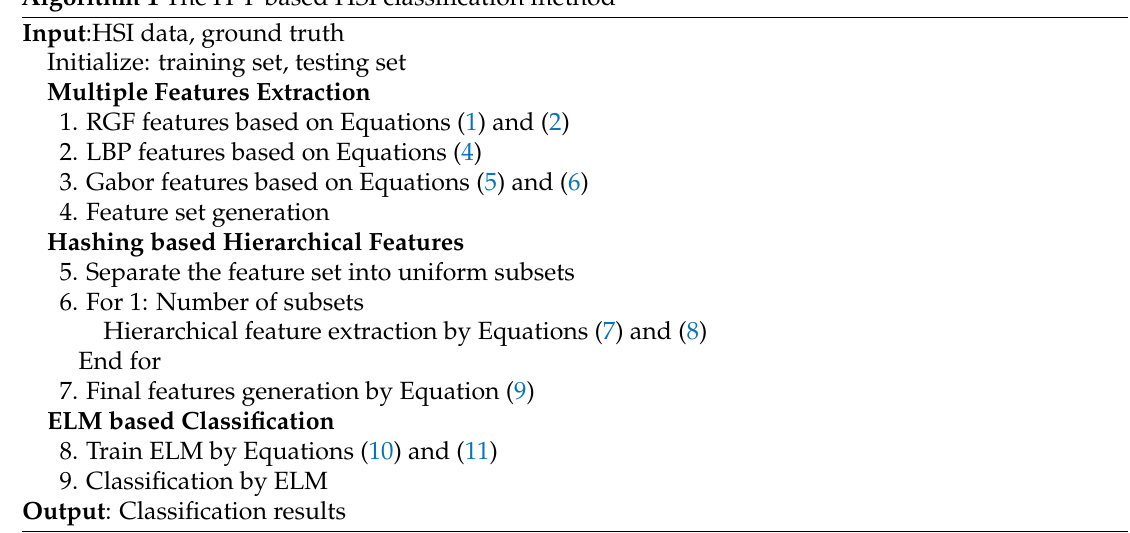
Algorithm 1 The H 2 F based HSI classification